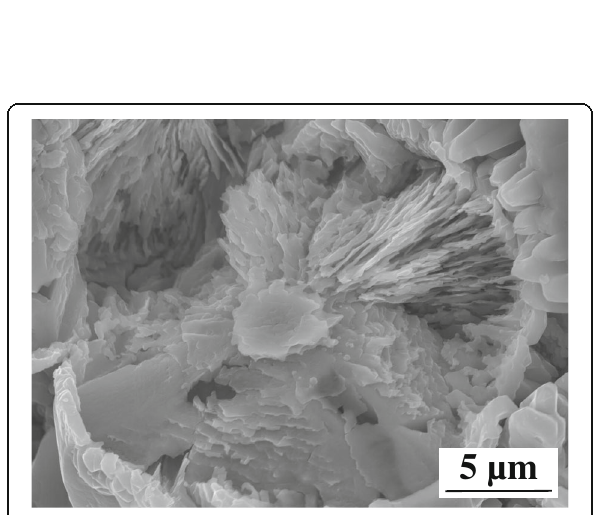
Fig. 7 SEM image of the internal structure of Co 3 O 4 /ZnO-35